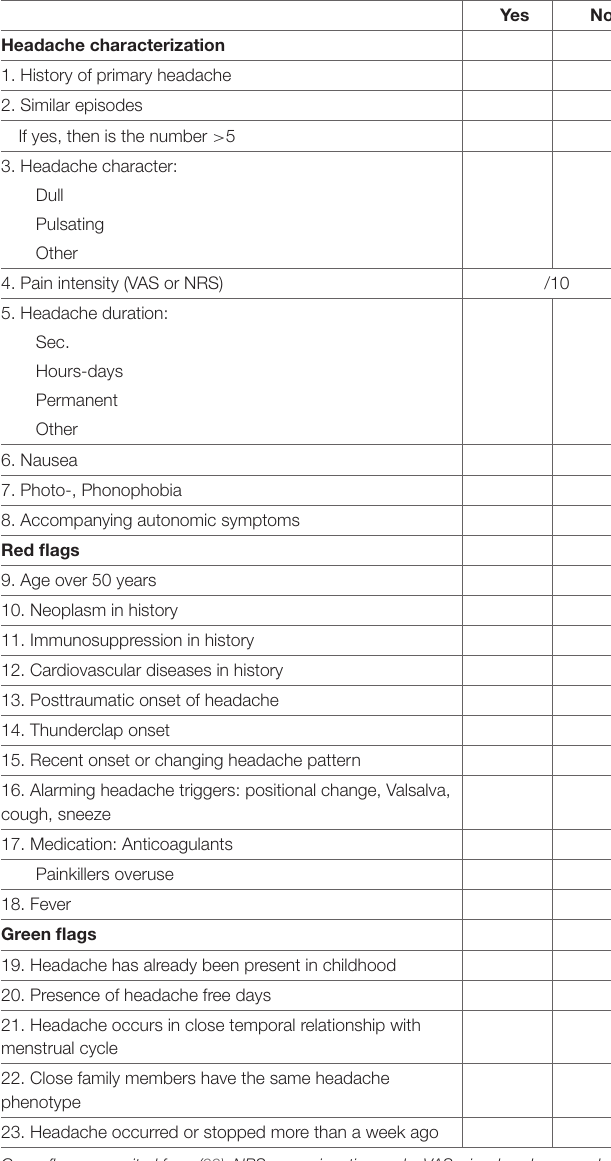
TABLE 3 | Structured headache history: core headache characteristics, red and green flags.